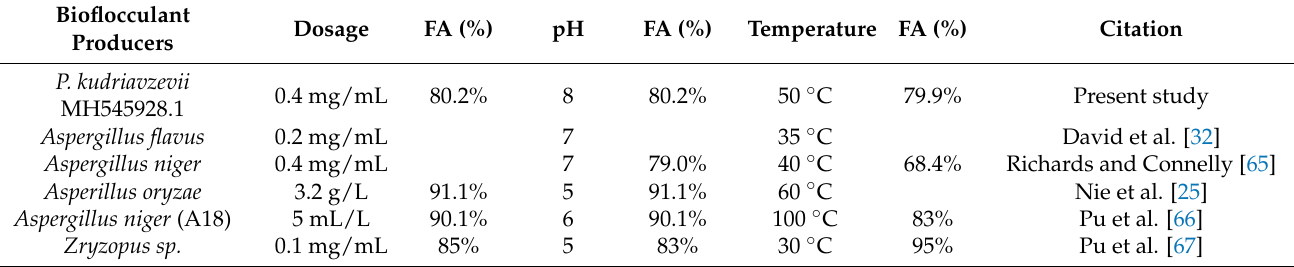
Table 3. Characteristics of bioflocculant from P. kudriavzevii MH545982.1 vs. bioflocculant from other fungi.